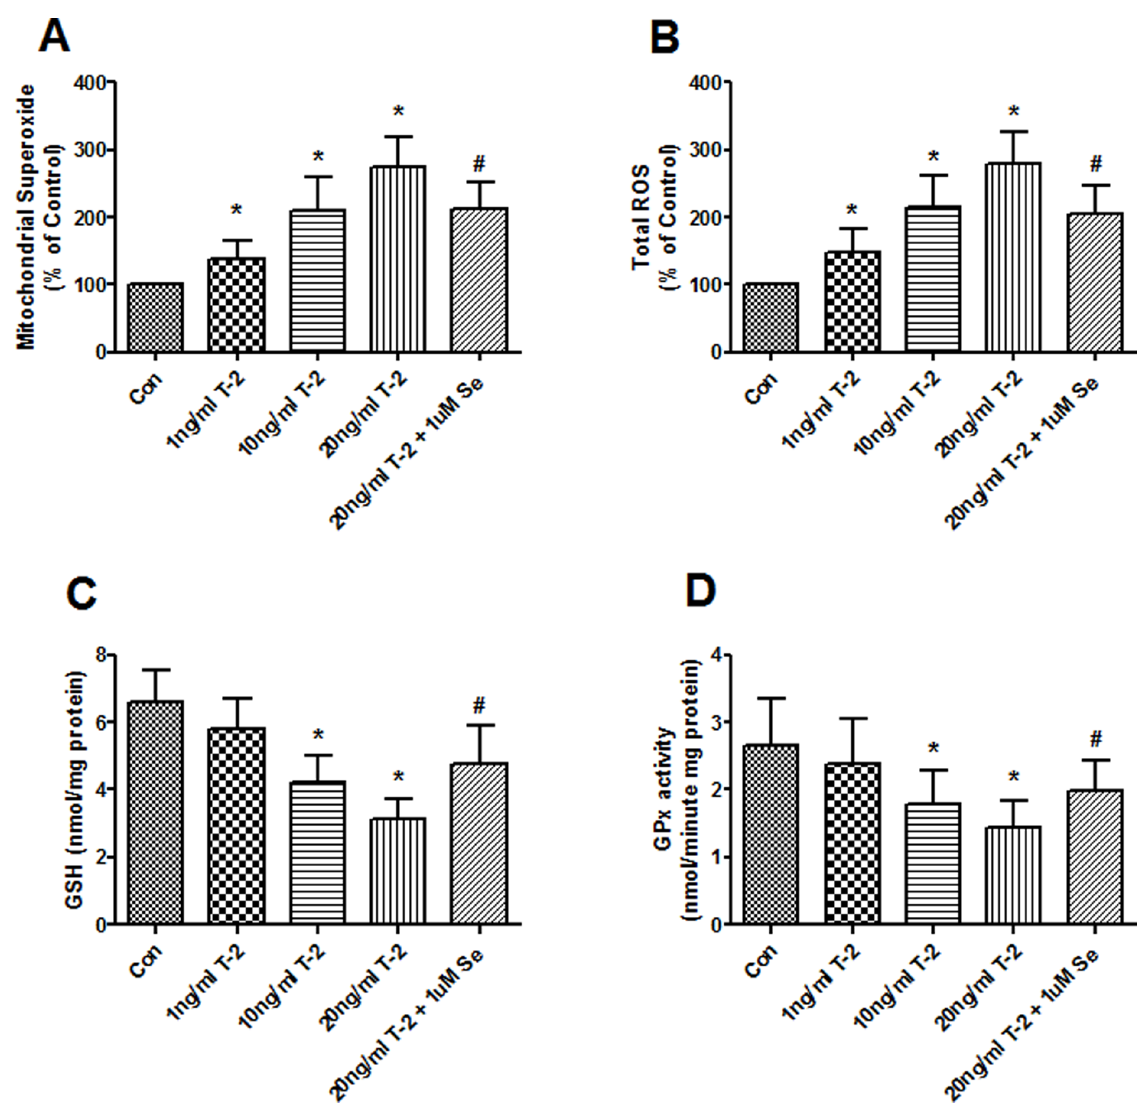
Figure 3. Effects of T-2 toxin on ROS and antioxidants generation. The production of ROS at mitochondrial ( A ) and cytoplasmic ( B ) level was assessed by MitoSOX red mitochondrial superoxide indicator and Carboxy-H 2 DCFDA probe (both from Invitrogen), respectively. GSH concentration (C) and GPx activity (D) were measured by coupled enzyme assay as described under ‘‘Materials and methods’’. Chondrocytes were incubated with1, 10, 20 ng/ml T-2 toxin and 1 uM Na 2 SeO 3 + 20 ng/ml T-2 toxin for 5 d. * P , 0.01 vs. control; # P , 0.01 vs. 20 ng/ml T-2 toxin group.